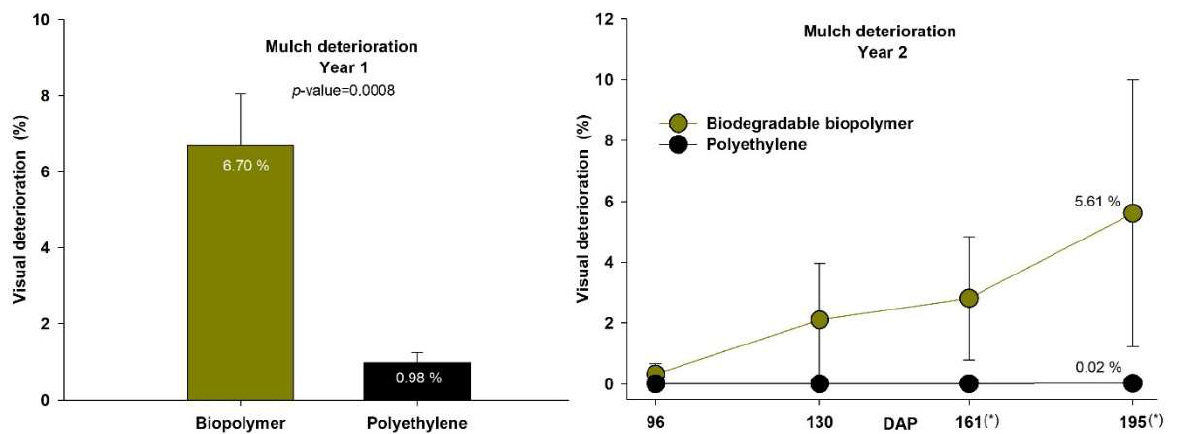
Figure 7. Visual deterioration of plastic mulches (biodegradable biopolymer and polyethylene) at the end of the crop season in Year 1 of the study, and during the crop season in Year 2. Values (mean ± standard deviation; n = 3). ‘*’ indicates significance at p ≤ 0.05 ( t -Student test). DAP: Days After Planting.